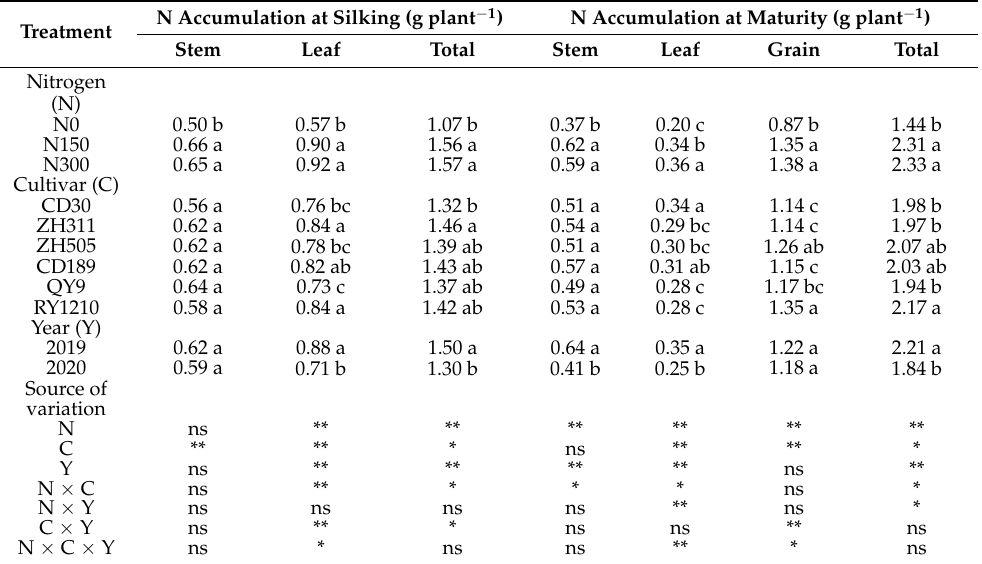
Table 3. Evaluation of N accumulation traits of six cultivars under three nitrogen (N) conditions.